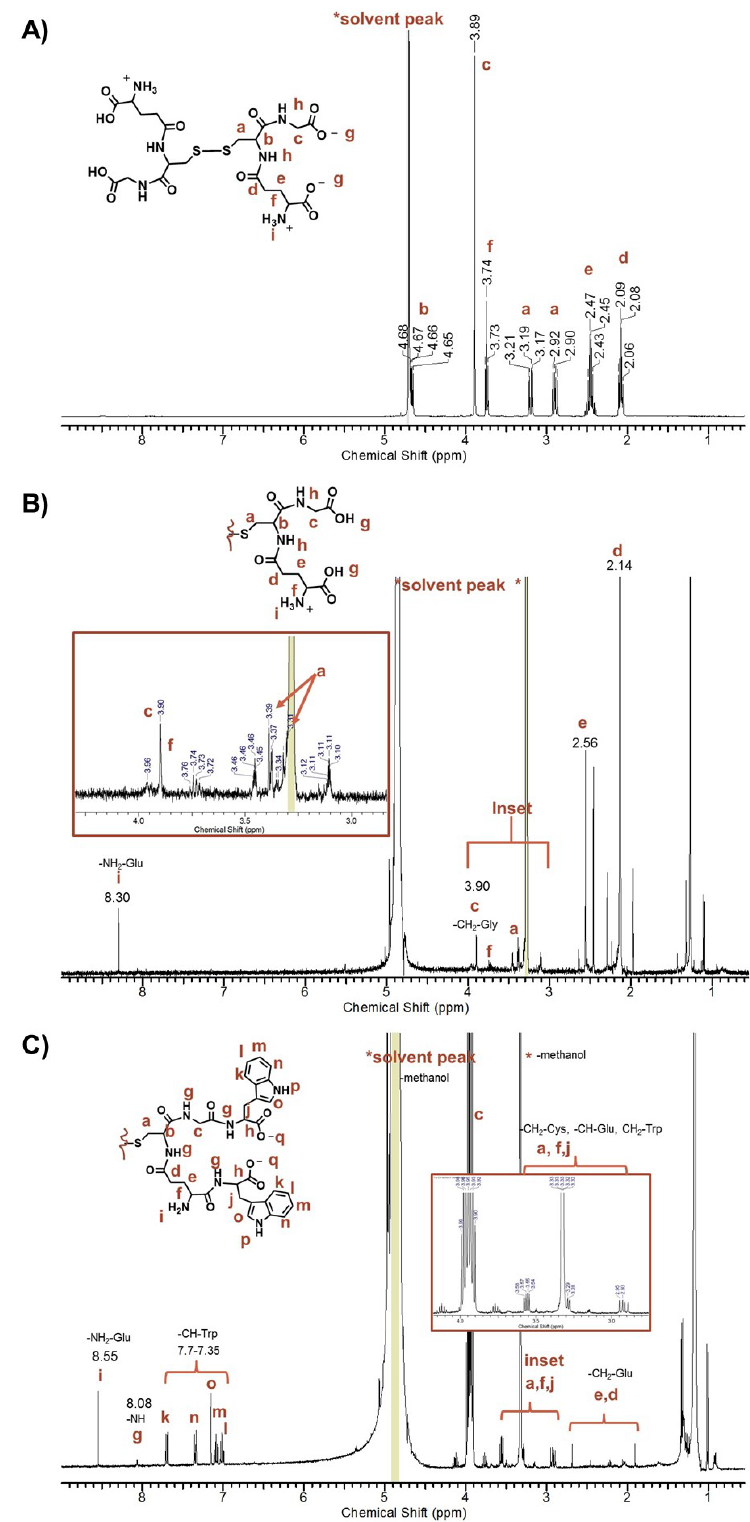
etched with excess 2